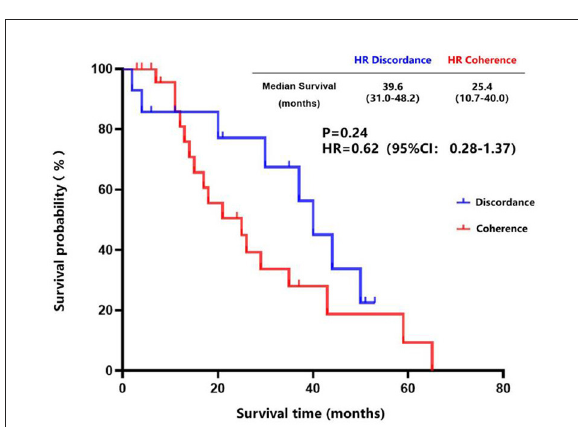
FIGURE6 Survival curves of patients with consistent HR expression vs. patients with inconsistent HR expression after diagnosis of brain